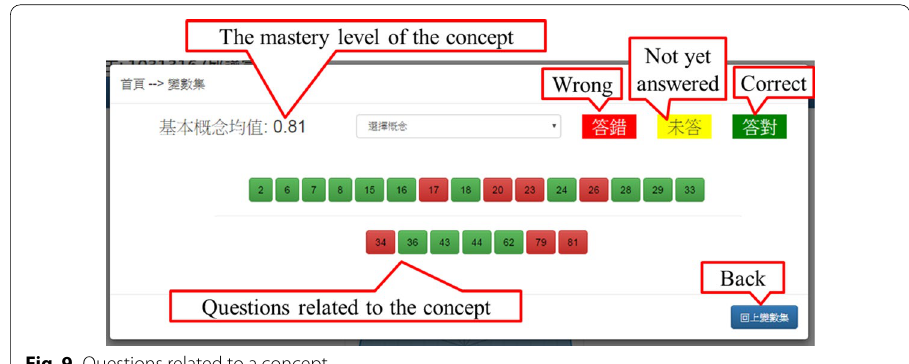
Fig. 9 Questions related to a